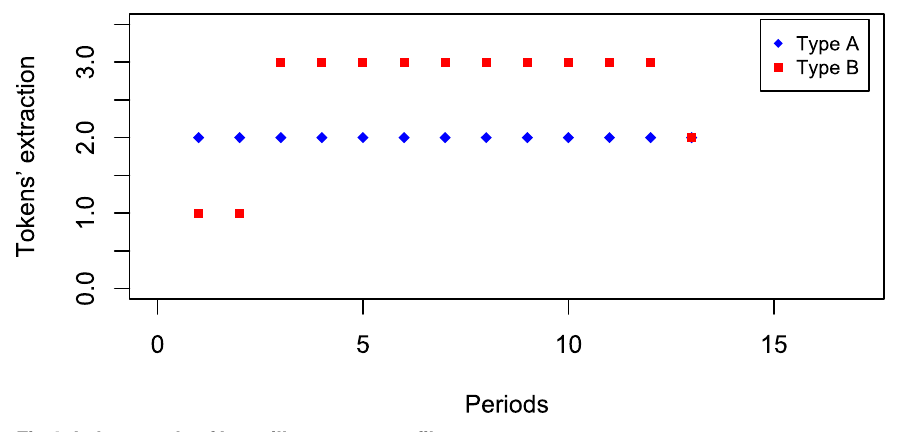
Fig 4. Lab example of Lazarillo